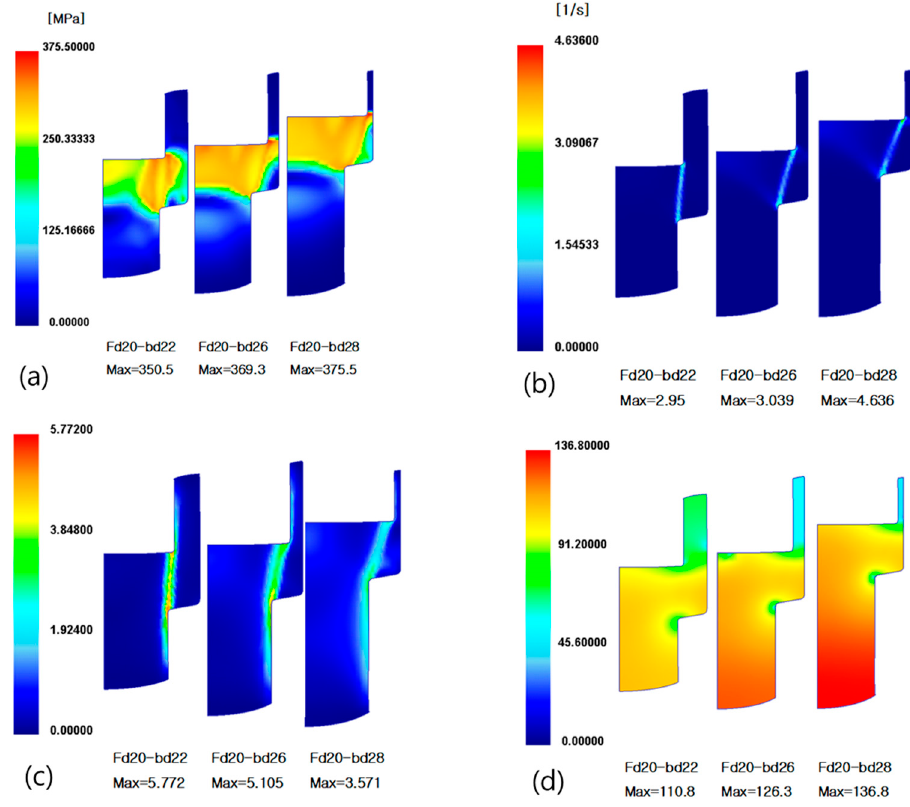
Figure 4. Distribution of ( a ) effective stress; ( b ) effective strain rate; ( c ) effective strain; and ( d ) temperature predicted by finite element analyses for the CFBE processes of AZ31B Mg alloy.